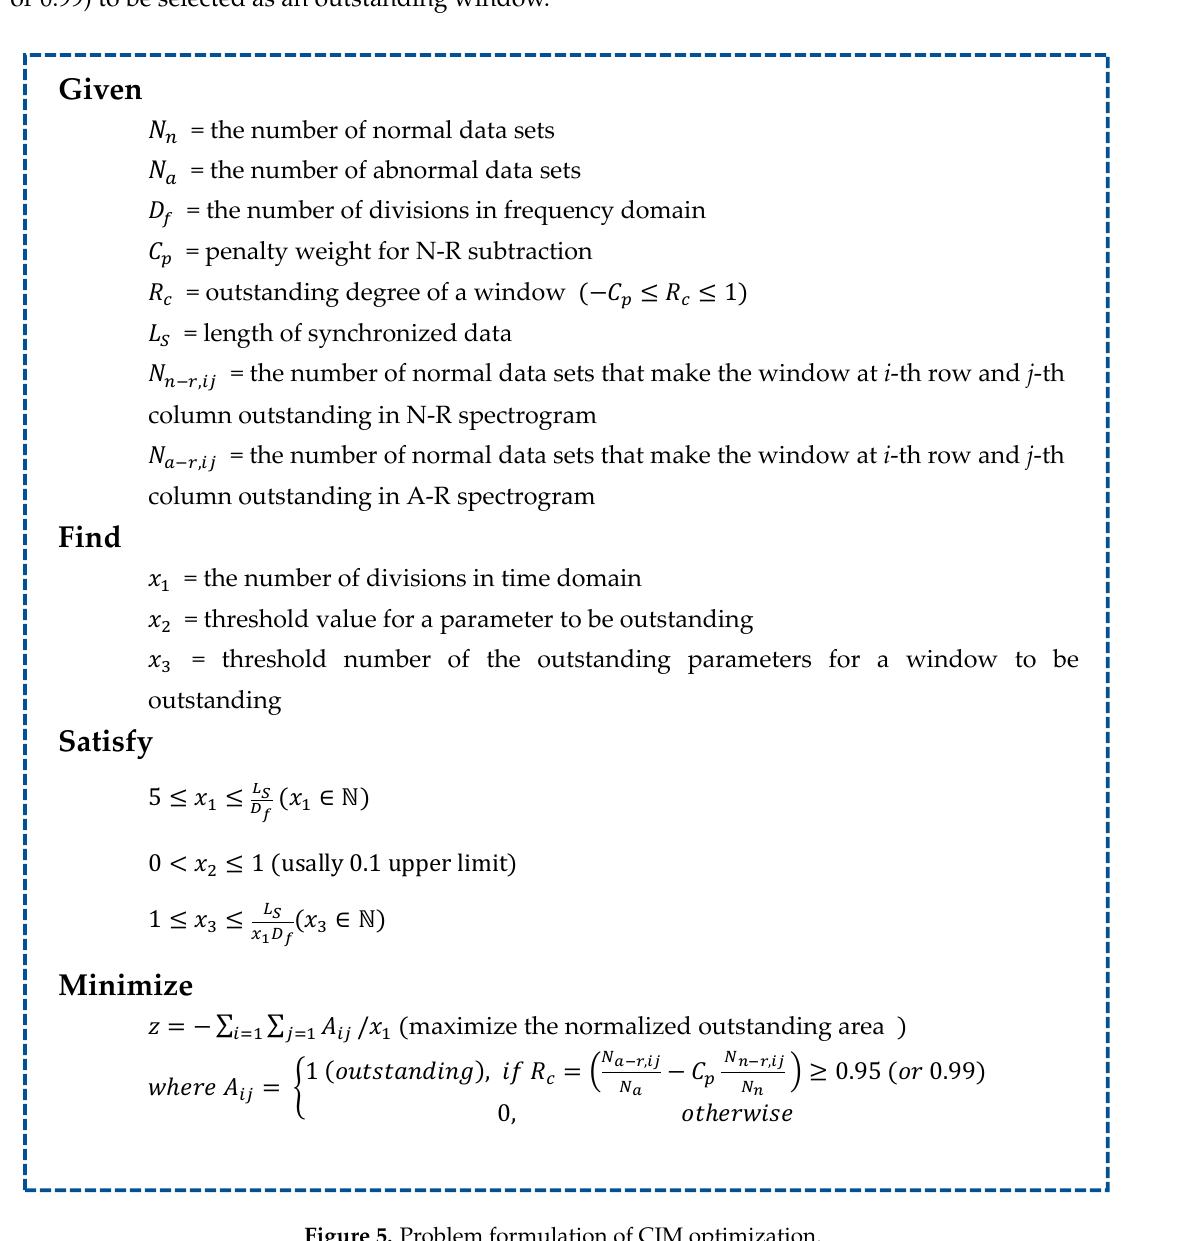
Figure 5. Problem formulation of CIM optimization.